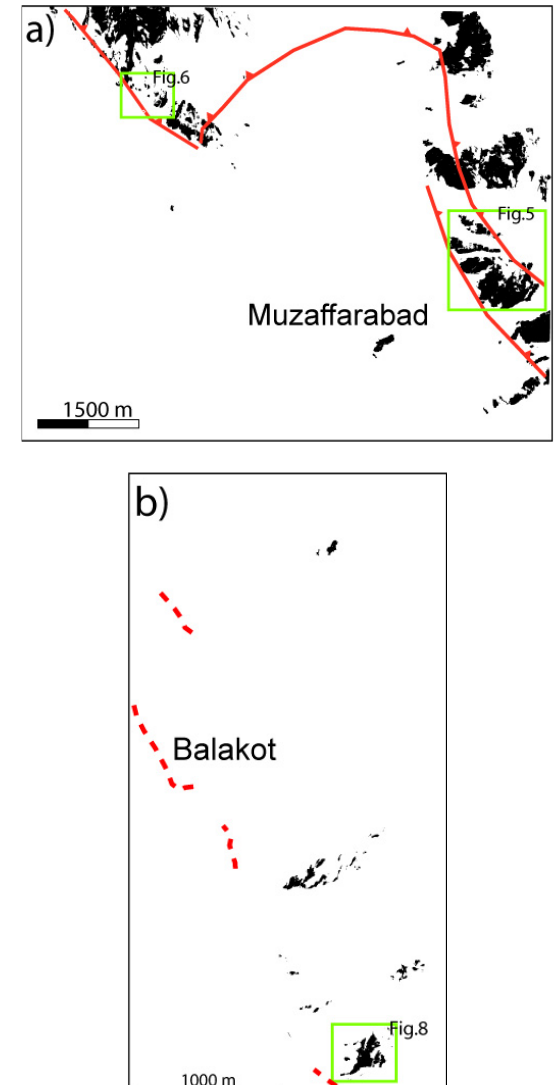
Fig. 9. Maps of the landslides (black areas) occurring in the whole area covered by the images, (a) Muzaffarabad, (b) Balakot, detected by the automatic classification. Green boxes include the landslides detail shown in Figs. 5, 6 and 8. The red line is the fault